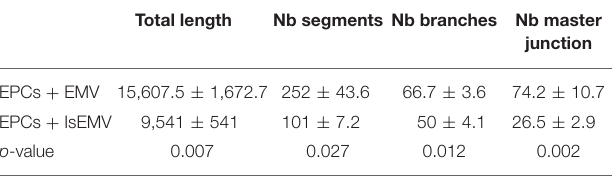
TABLE 2 | Angiogenic parameters. Total